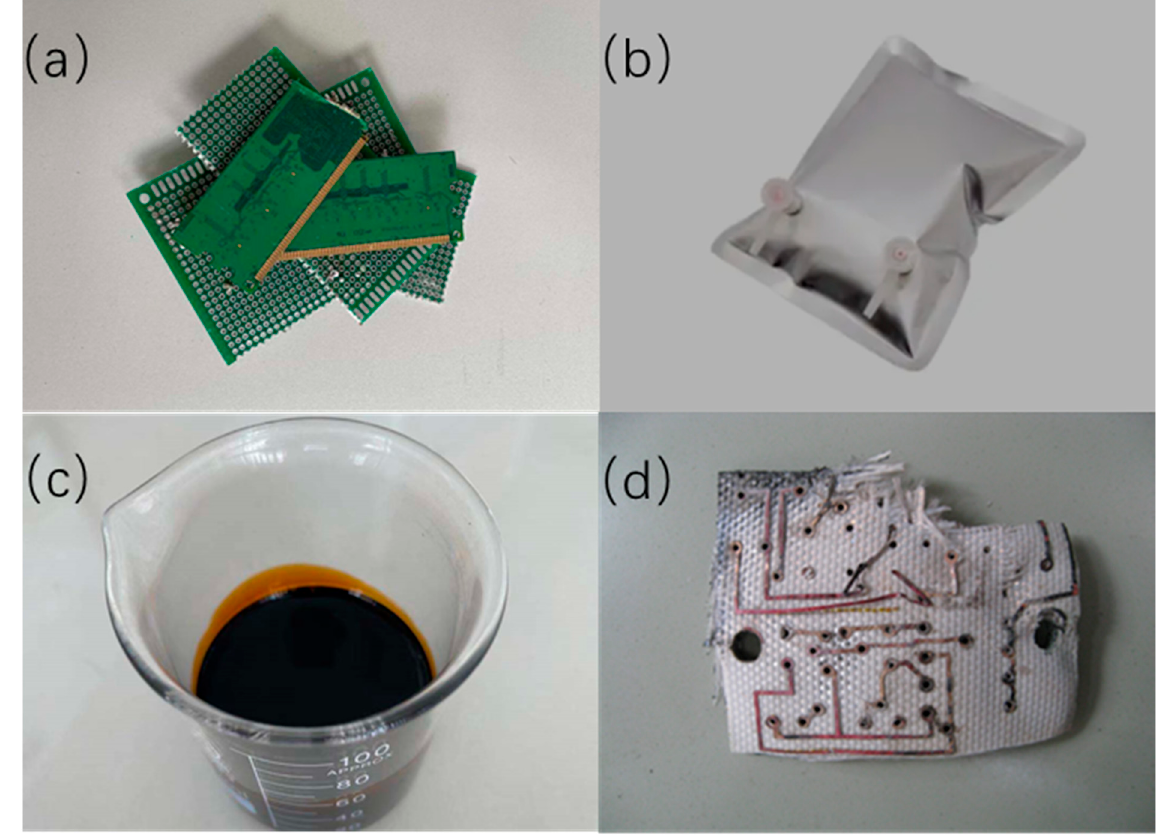
Figure 4. WPCBs ( a ) and the pyrolysis products in gas ( b ), liquid ( c ), and solid ( d ) phase.